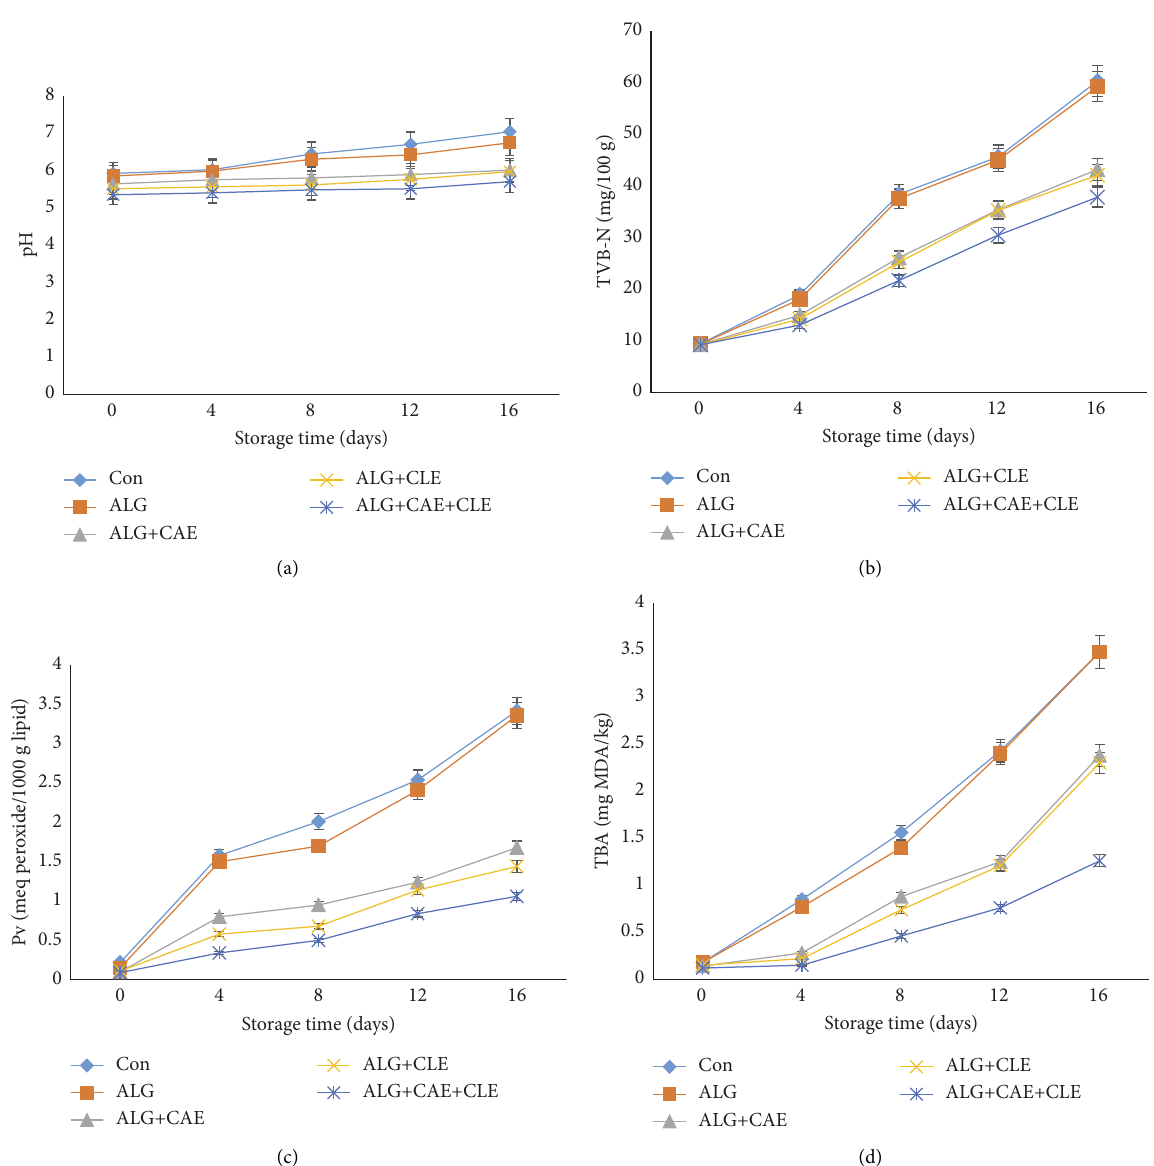
Figure 1: Changes in chemical of chicken fllet samples during refrigerated